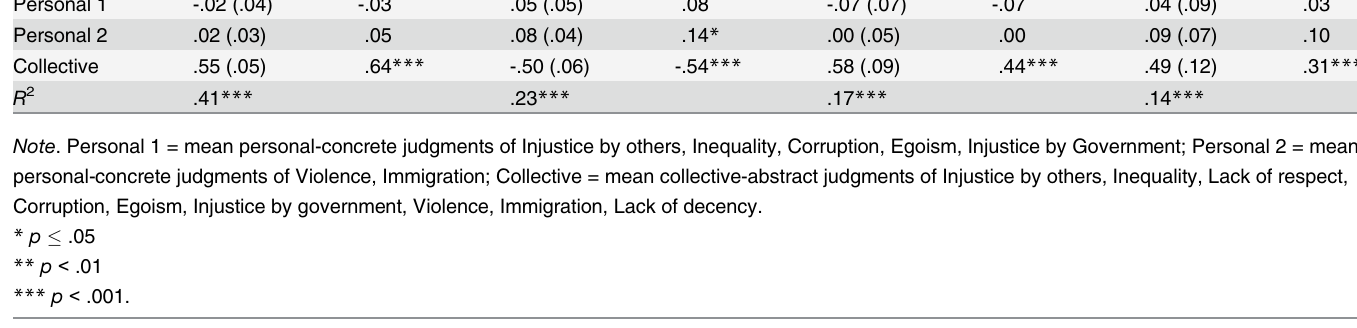
computed for two negative personal judgment factors (Factor 1: Injustice by others, Inequality, Corruption, Egoism, Injustice by Government ( α = .72) and Factor 2: Violence, Immigration ( α = .77)) and one collective judgment factor (Factor 1: Injustice by others, Inequality, Lack of respect, Corruption, Egoism, Injustice by government, Violence, Immigration, and Lack of decency ( α = .86)). Regression analyses were used to determine the influence of personal and